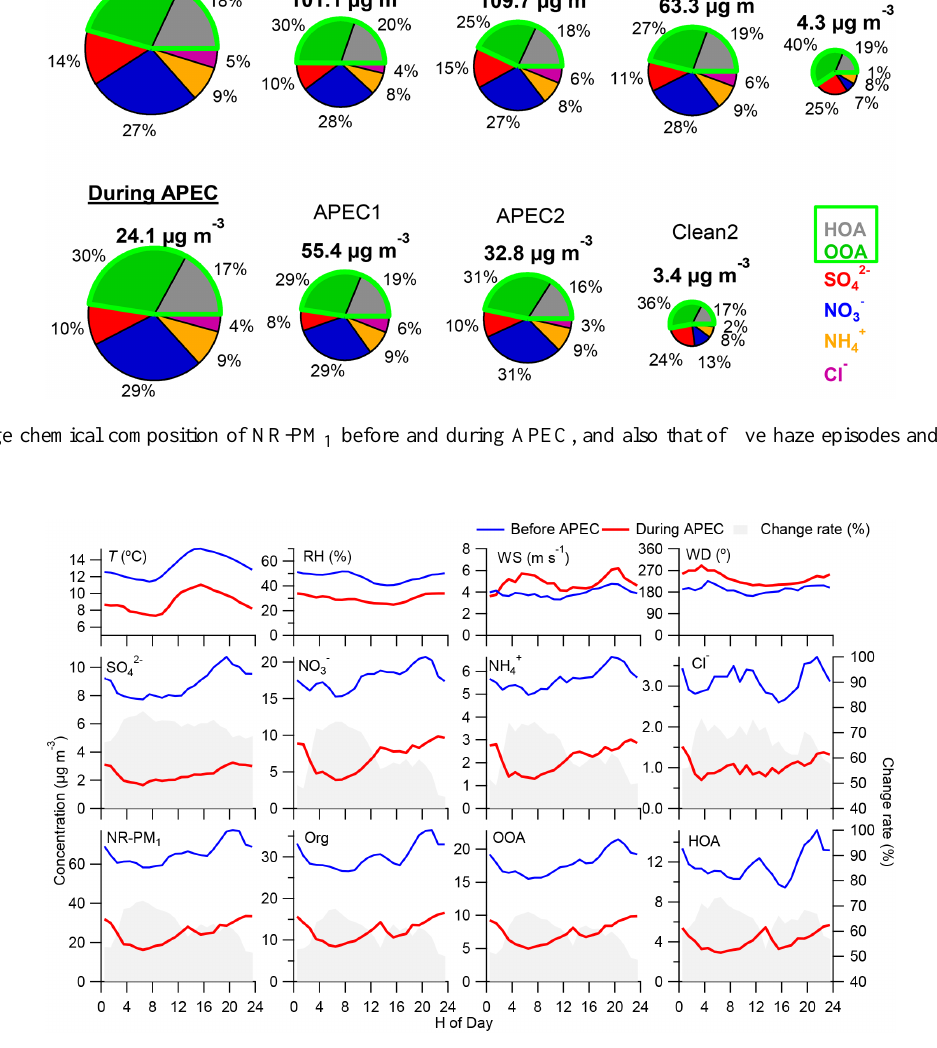
Figure 7. Diurnal variations of meteorological variables ( T , RH, WS, and WD), NR-PM 1 species, and OA factors before and during APEC. The change rates during APEC (i.e., (before APEC–APEC)/before APEC × 100) are also marked as light gray in the